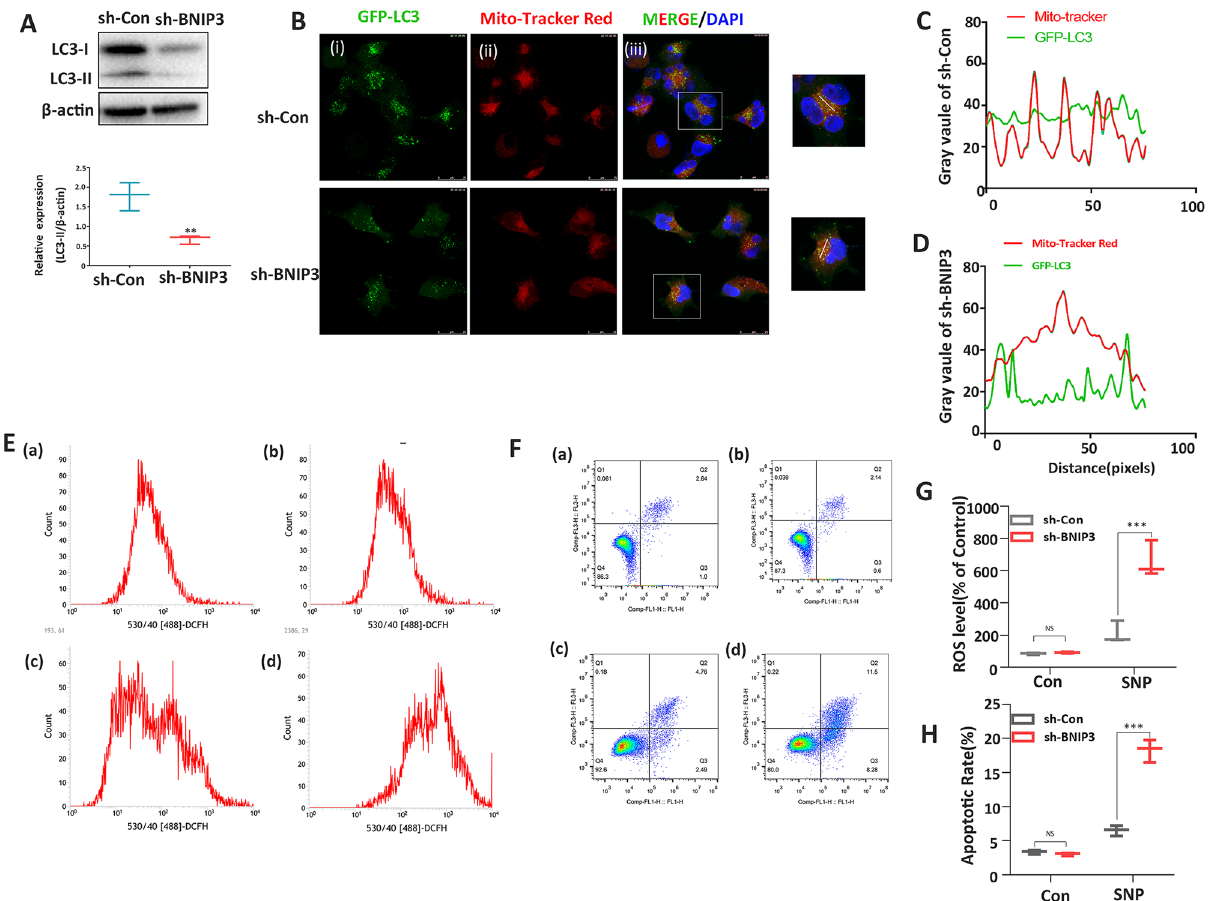
LC3-II, and β-actin after sh-BNIP3 transfection after SNP treatment (n = 3 per group). ( B ) Immunofluorescent analysis of colocalization of GFP ‐ LC3 and mitochondria under oxidative stress after sh-Control and sh-BNIP3 transfection (n = 3 per group). ( C , D ) Line scans of the co-localizations between GFP-LC3 (Green) and MitoTracker (Red) for sh-Control and sh-BNIP3 under oxidative stress. ( E ) Flow cytometric analysis of intracellular ROS in sh-Control ( a ), sh-BNIP3 ( b ), sh-control + SNP ( c ), and sh-BNIP3 + SNP ( d ) groups (n = 3 per group). ( F ) Flow cytometric analysis of apoptosis in sh-Control ( a ), sh-BNIP3 ( b ), sh-control + SNP ( c ), and sh-BNIP3 + SNP ( d ) groups (n = 3 per group). ( G ) Statistical analysis for flow cytometric analysis of intracellular ROS. ( H ) Statistical analysis for flow cytometric analysis of apoptosis. NS non-significant, *p-values < 0 05, **p-value < 0.01, *** p -values < 0.001. Full-length blots are presented in Supplementary Figure